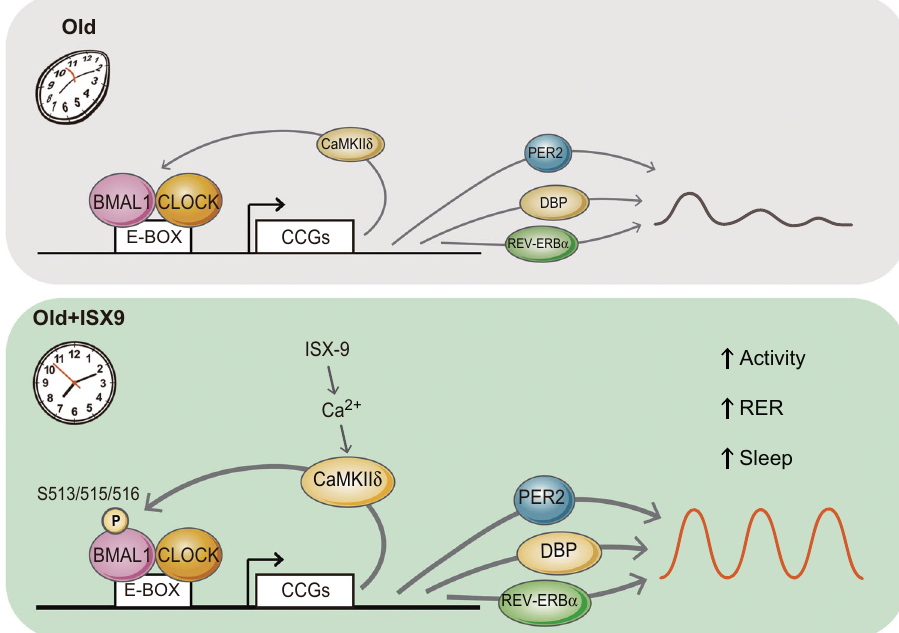
Fig. 7 Model of ISX-9 effect through CaMKII δ -mediated activation of BMAL1 for circadian amplitude enhancement. Aging is commonly associated with the declined circadian amplitude of clock gene expressions, decreased locomotor activity, and reduced sleep homeostasis. ISX-9 facilitates Ca 2 + in fl ux further triggers BMAL1 S513/515/516 phosphorylation in a CaMKII δ -dependent manner in aging cells. The effect, in turn, upregulates the expression clock outputs, including PER2, DBP, and REV-ERB α , and promotes locomotor activity, daily RER fl uctuation, and sleep homeostasis in middle-aged mice. Given that CaMKII δ is a clock-controlled protein that also dampens with aging, ISX-9 stimulation helps to intensify a positive feedback loop through CaMKII δ to modulate BMAL1 activity, therefore, reverts the circadian amplitude decay caused by